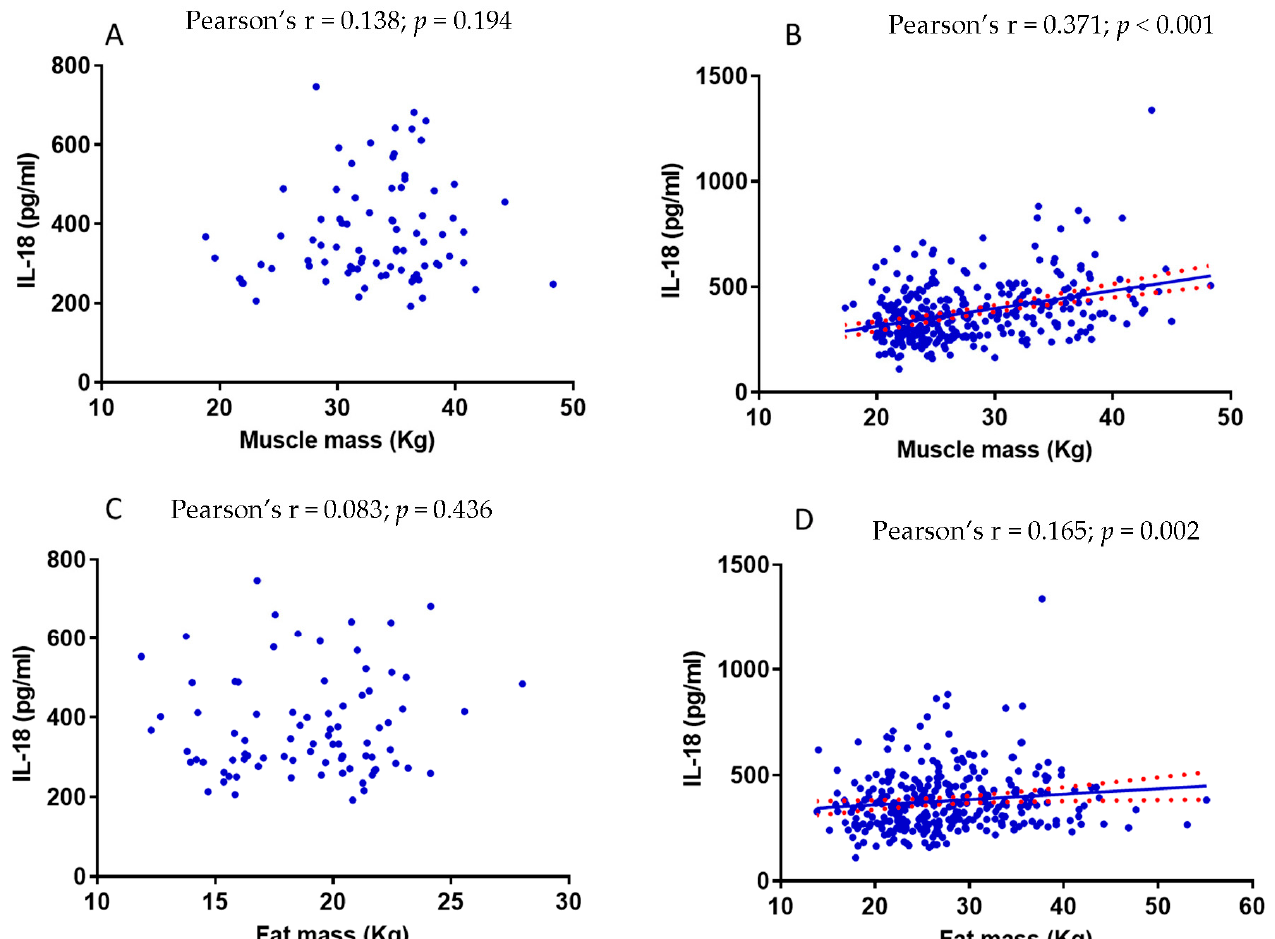
Figure 3. Pearson correlation analysis between IL-18 circulating levels and ( A ) muscle mass in subjects with fat mass < 30%; ( B ) muscle mass in subjects with fat mass ≥ 30%; ( C ) fat mass in subjects with fat mass < 30% and ( D ) fat mass in subjects with fat mass ≥ 30%. Data analysis was performed using log transformation. Pearson’s r, Pearson correlation coe ffi cient.